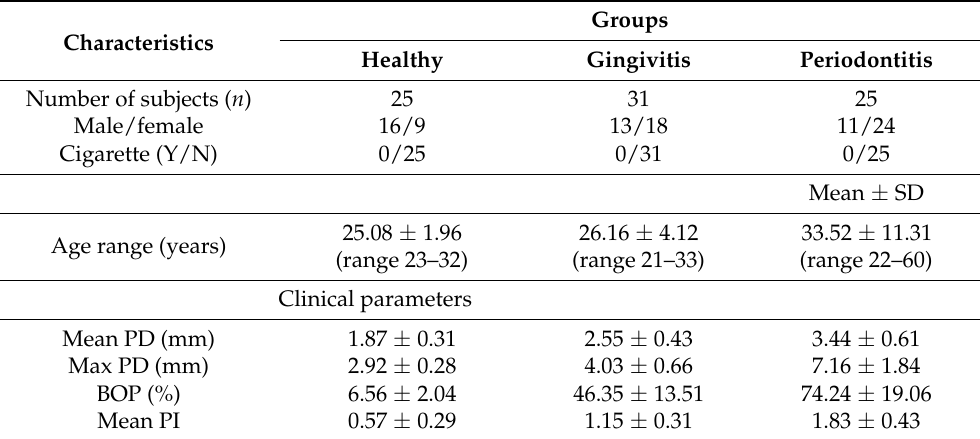
Table 1. Patient demographics and clinical parameters.